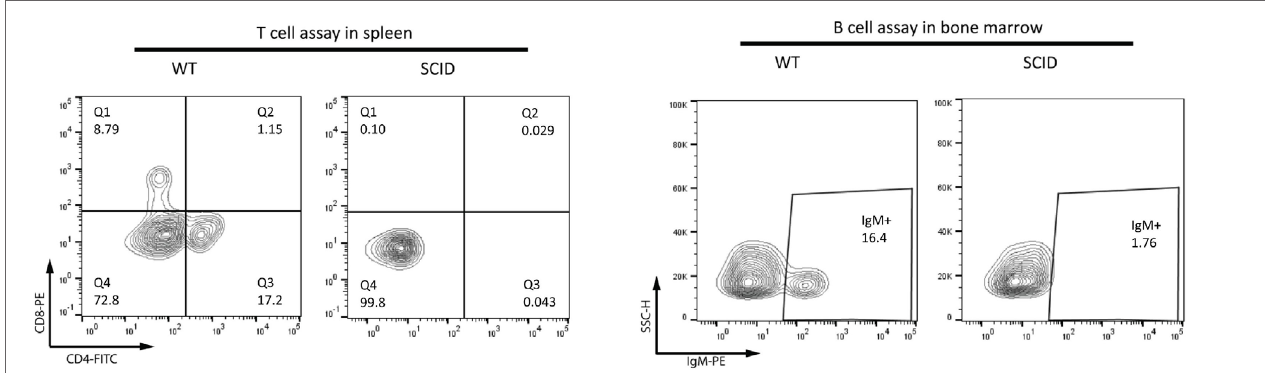
FigUre 2 | Founder severe combined immunodeficiency (SCID) rabbits have combined immunodeficiency. (a) Summary of complete blood count (CBC) results. (B) Representative flow cytometry results of SCID rabbit. (c) Summary of flow cytometry results of B- and T-cells in peripheral blood (PB) in all founder SCID rabbits. (D) Thymus in SCID and wild-type (WT) rabbits. (e,F) Histology of spleen and thymus in SCID founder rabbit. In contrast to WT animals (e) , spleens from knockout (KO) animals (F) were almost completely devoid of lymphocytes, save for a few small clusters of cells (arrowhead). Similarly, the thymus in WT animals (g) had normal cortical thickness (arrowheads) and dense cortical lymphocytes, while thymus from KO animals (h) had complete loss of the thymic cortical structure with almost no lymphocytes present, within a background of thymocytes and supporting stroma. (i) Flow cytometry results of B- and T-cells harvested from spleen and bone marrow. Representative individual results and images are from animal #194 unless otherwise